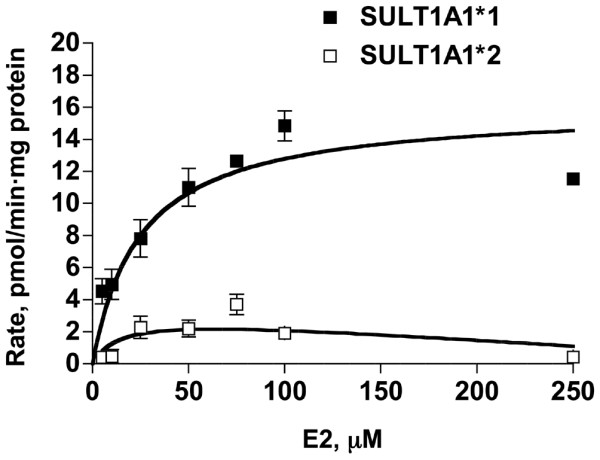
17β-estradiol (E2) sulfation by recombinant SULT1A1 allozymes. SULT1A1*2 has lower capacity to sulfate E2 than SULT1A1*1. One hundred nanograms of purified recombinant SULT1A1*1 and SULT1A1*2 allozymes were evaluated for capacity to sulfate E2 in a radiometric sulfotransferase assay. Assay conditions included 10 μM 3'-phosphoadenosine-5'-phosphosulfate (the sulfate donor) and increasing concentrations of E2 (0–250 μM). Data were evaluated on GraphPad Prism 3.0b (GraphPad Software Inc..) and fit to the Michaelis-Menten equation. SULT1A1*1, Km = 25.73 ± 7.28 μM, Vmax = 17.5 ± 1.71 pmol/min per mg protein; SULT1A1*2, Km = 24.74 ± 20.24 μM, Vmax = 3.55 ± 0.99 pmol/min per mg protein (Vmax, P < 0.0001).